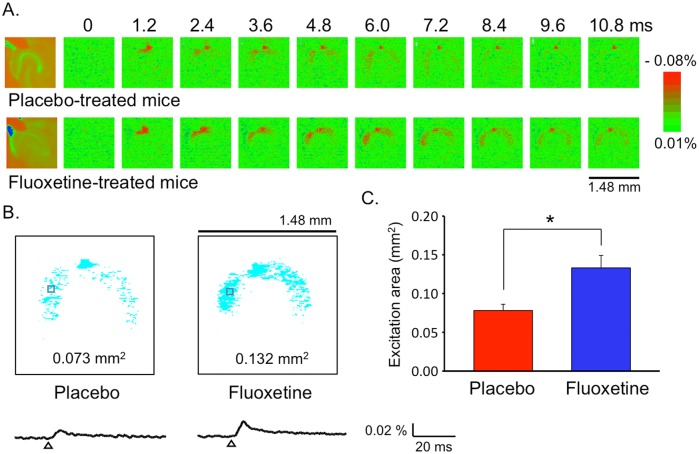
Effect of chronic fluoxetine treatment on optical responses in the hippocampal DG.(A) Effect of chronic fluoxetine treatment on optical responses evoked by the stimulation of the perforant path inputs in hippocampal slices. The left-most panel shows the pseudocolor image of the slice preparation in which the optical recordings were made. A series of optical images of neuronal activity were recorded at 1.2-ms intervals from 0 to 10.8 ms after nerve stimulation. The signal intensity, expressed as fractional changes in optical absorbance relative to the background (%), was coded by the pseudocolor image. (B, C) The maximum propagation area of the optical signal above the background noise was analyzed 7.2–9.6 ms after stimulation, when the activation of the dendrites of the GCs via glutamatergic synaptic transmission was detected (see S1 Fig). Typical images of the excitation area (B), traces of the optical responses at the boxed area (B) and the quantified excitation area (C) are shown in mice treated with placebo (n = 16 slices from 8 mice) and fluoxetine (n = 19 slices from 9 mice). *p < 0.001 compared with placebo-treated mice; Mann-Whitney U-test (U = 50, p = 0.0008). The preliminary data used for these figures are reported in a review article in Japanese [71].